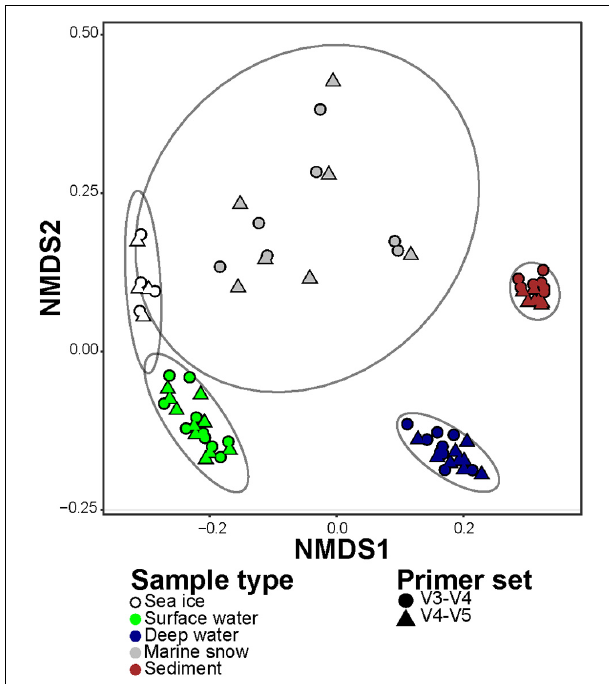
FIGURE 4 | Non-metric Multi-dimensional Scaling (NMDS) of the microbial communities in merged V3–V4 and V4–V5 datasets, based on Jensen-Shannon Divergence. The different types of samples are represented by colors, and the primer set are represented by shapes. Ellipses encompass clustering of each microbiome type with normal confidence of 0.95.